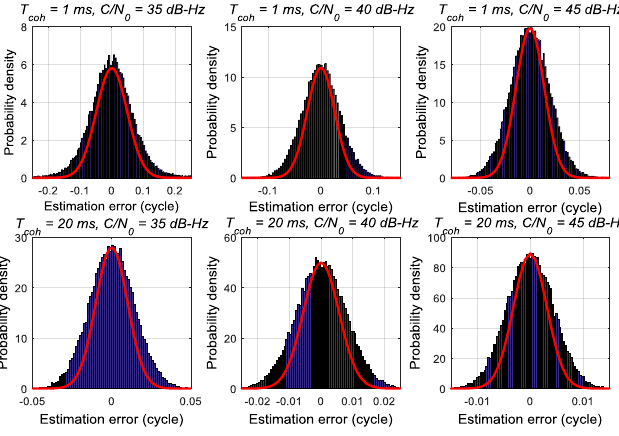
Figure 2. The estimation noise distribution of ATAN discriminator in different T coh and C / N 0 .